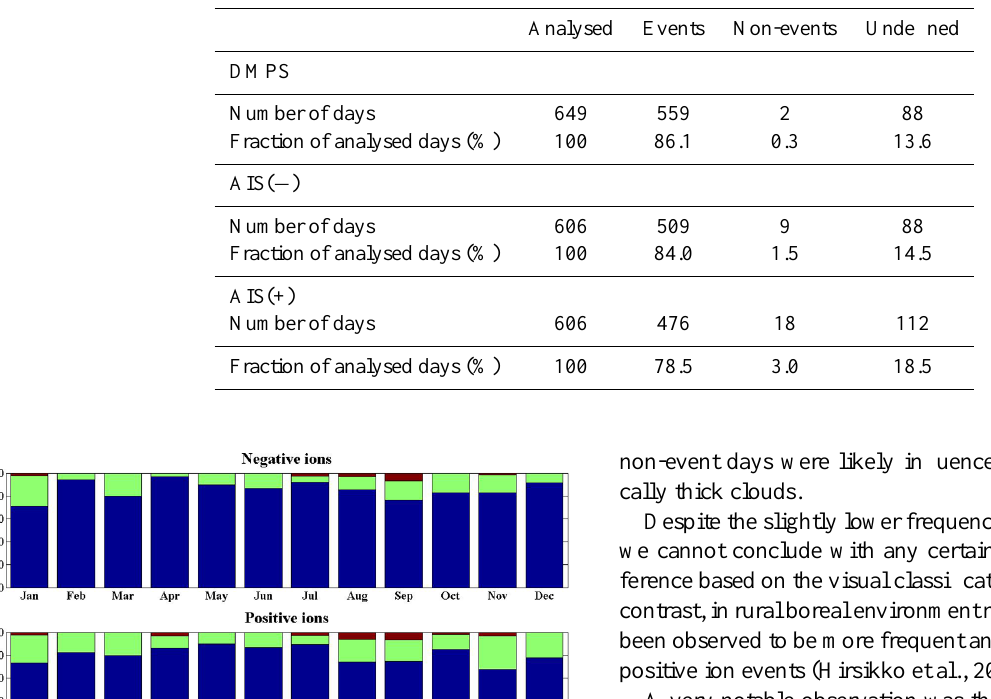
Table 3. Statistics of nucleation event day classification based on the DMPS and the AIS data.